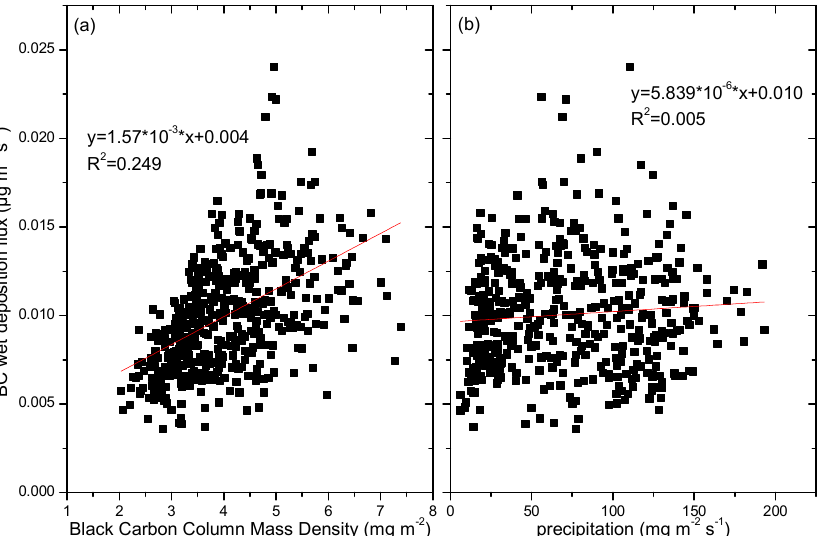
Figure 8. Relations between BC wet deposition flux and BC column mass density ( a ), and precipitation ( b ).